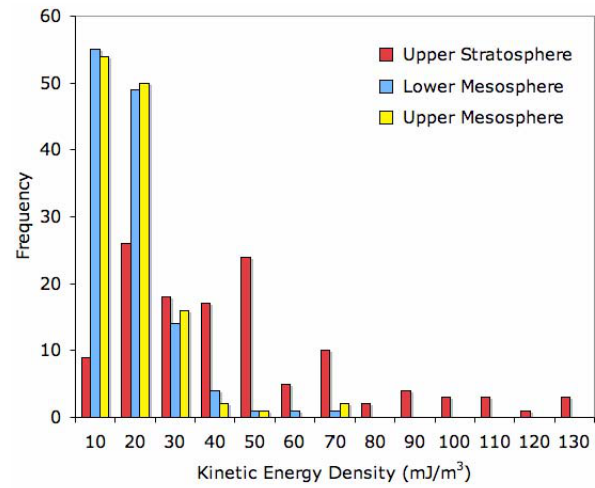
Fig. 6. Histogram of the nightly-averaged kinetic energy density for the upper stratosphere (30 to 50km), lower mesosphere (45 to 65km) and upper mesosphere (60 to 80km). Many more nights have smaller kinetic energy densities in the mesosphere than in the upper stratosphere, suggesting a loss of wave energy in the stratosphere.